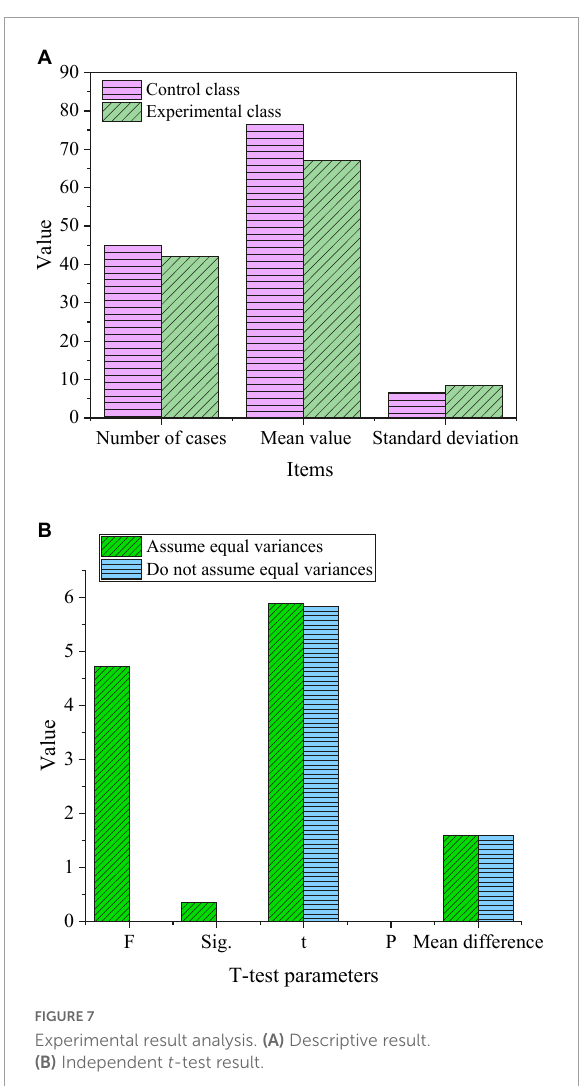
FIGURE7 Experimental result analysis. (A) Descriptive result. (B) Independent t -test result.